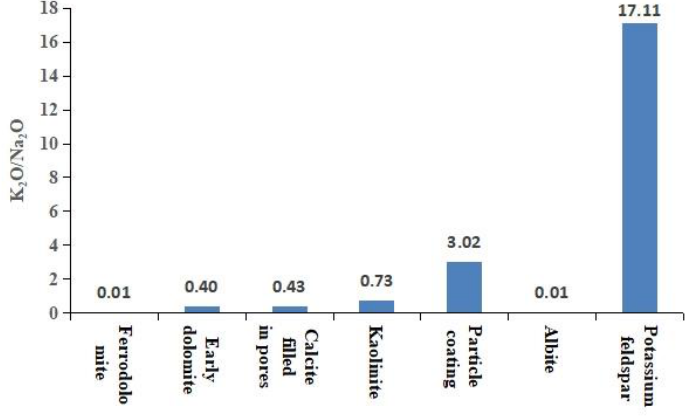
Figure 8. ( a ) The particle coating is coated with two-stage calcite, Q9-3, 2174.8 m. ( b ) Element distri- bution characteristics of particle coating and typical illite.